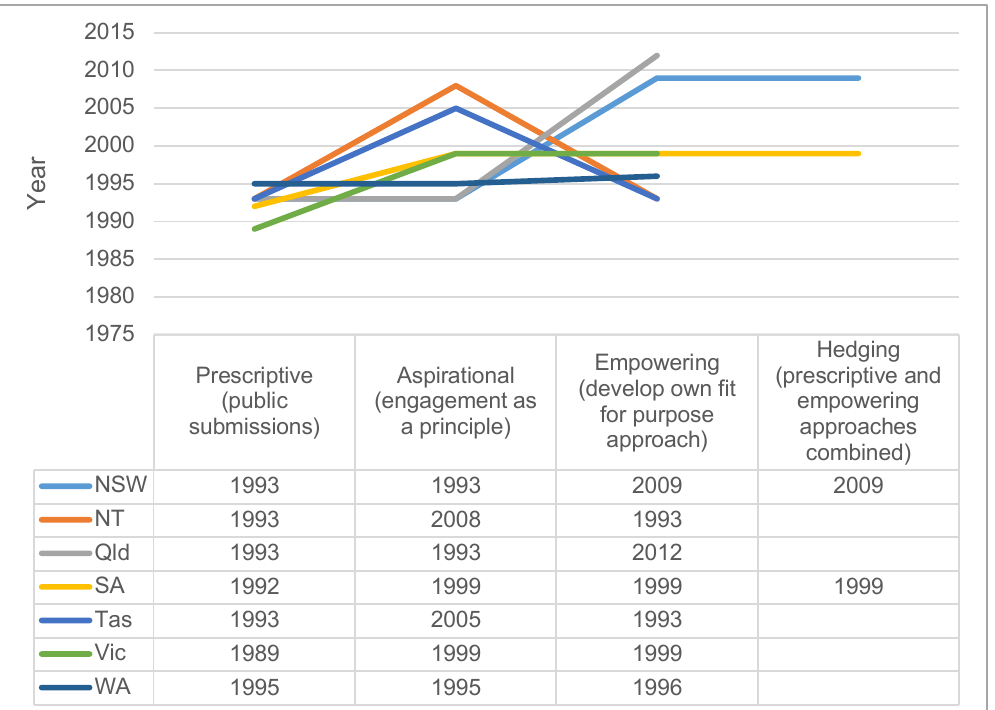
Figure 2: Developmental stages in Australian Local Government Acts as pertaining to community